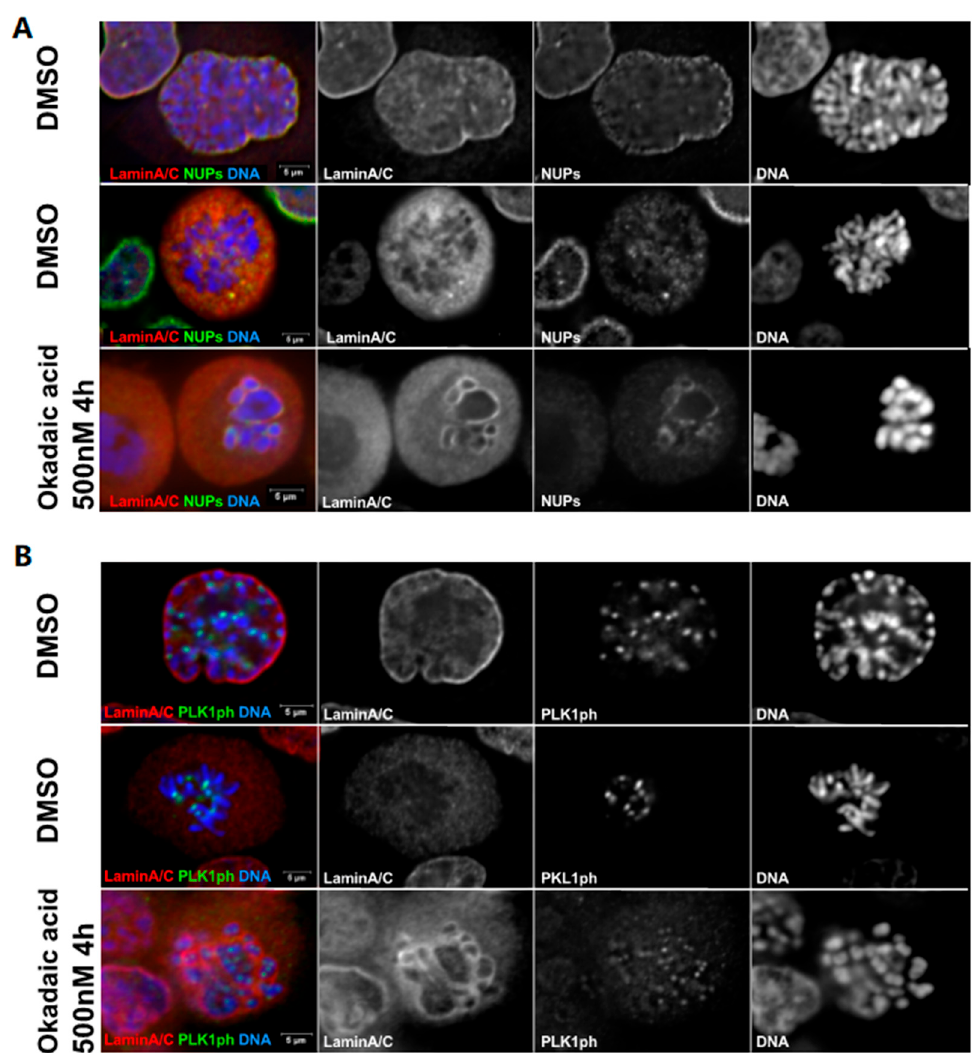
Figure 2. Okadaic acid triggers chromosome condensation but not complete NE break down. HeLa cells were treated with DMSO or 500 nM okadaic acid for 4 h, then fixed and stained for ( A ) Lamin A / C (red) and mAb44 (NPC components, green) or ( B ) phospho-PLK1 (T210) (green) and Lamin A / C (red). ( A ) In prophase, Lamin A / C and NUPs are not completely disassembled and chromosomes start condensing (top panel) while in prometaphase Lamin A / C and NUPs are completely disassembled and dispersed in the cytoplasm (middle panel). Upon okadaic acid treatment, chromosome condensation is as advanced as in prometaphase but Lamin A / C and NUPs are not completely disassembled and are still present around chromosomes (bottom panel). ( B ) In prophase, when Lamin A / C are still not disassembled, phosphorylated PLK1 (PLK1ph) already accumulates at the centromeres (top panel). In prometaphase, Lamin A / C is fully dispersed in cytoplasm and PLK1ph localizes to the centromeres (middle panel). After okadaic acid treatment, chromosomes are condensed similar to prometaphase, Lamin A / C are not completely disassembled and PLK1 starts accumulating at the centromeres (bottom panel).